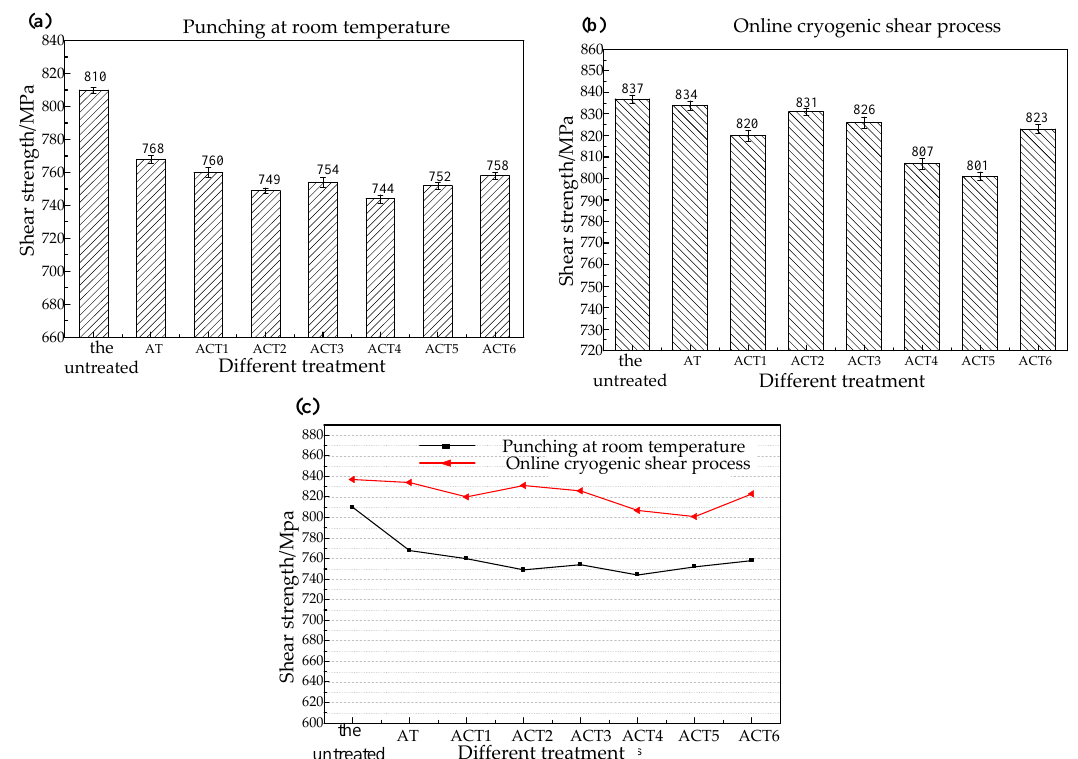
Figure 8. Shear strength at room and cryogenic temperature: ( a ) averaged shear strength at room temperature; ( b ) the averaged shear strength at cryogenic temperature; and ( c ) the comparison of shear strength.